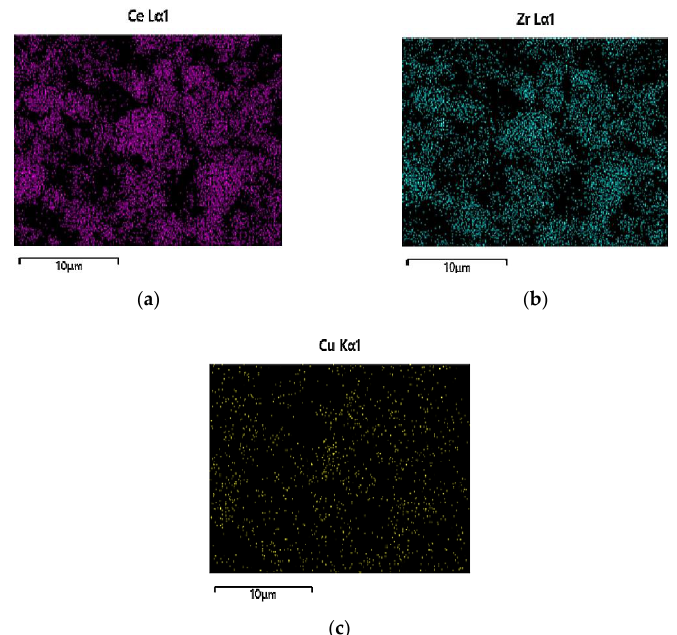
Figure 11. Distribution of: ( a ) Ce; ( b ) Zr; ( c ) Cu for PROM2 catalyst.